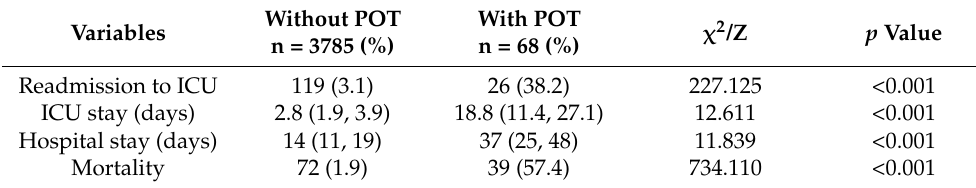
Table 4. Postoperative variables in patients with and without POTs after HVS.